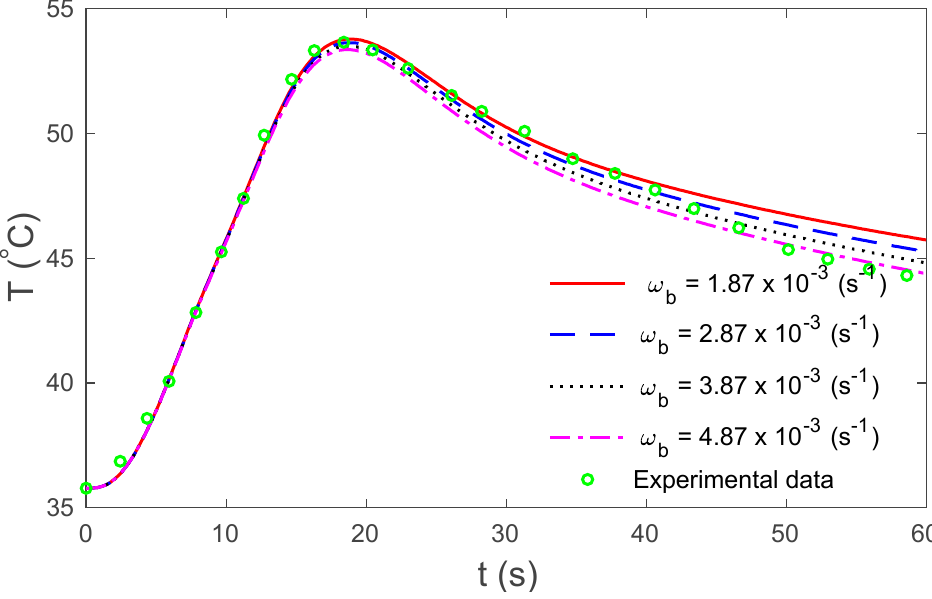
Figure 6. Temperature under the TPL model for several values of the rate of blood perfusion ω b at the skin surface in relation to time.